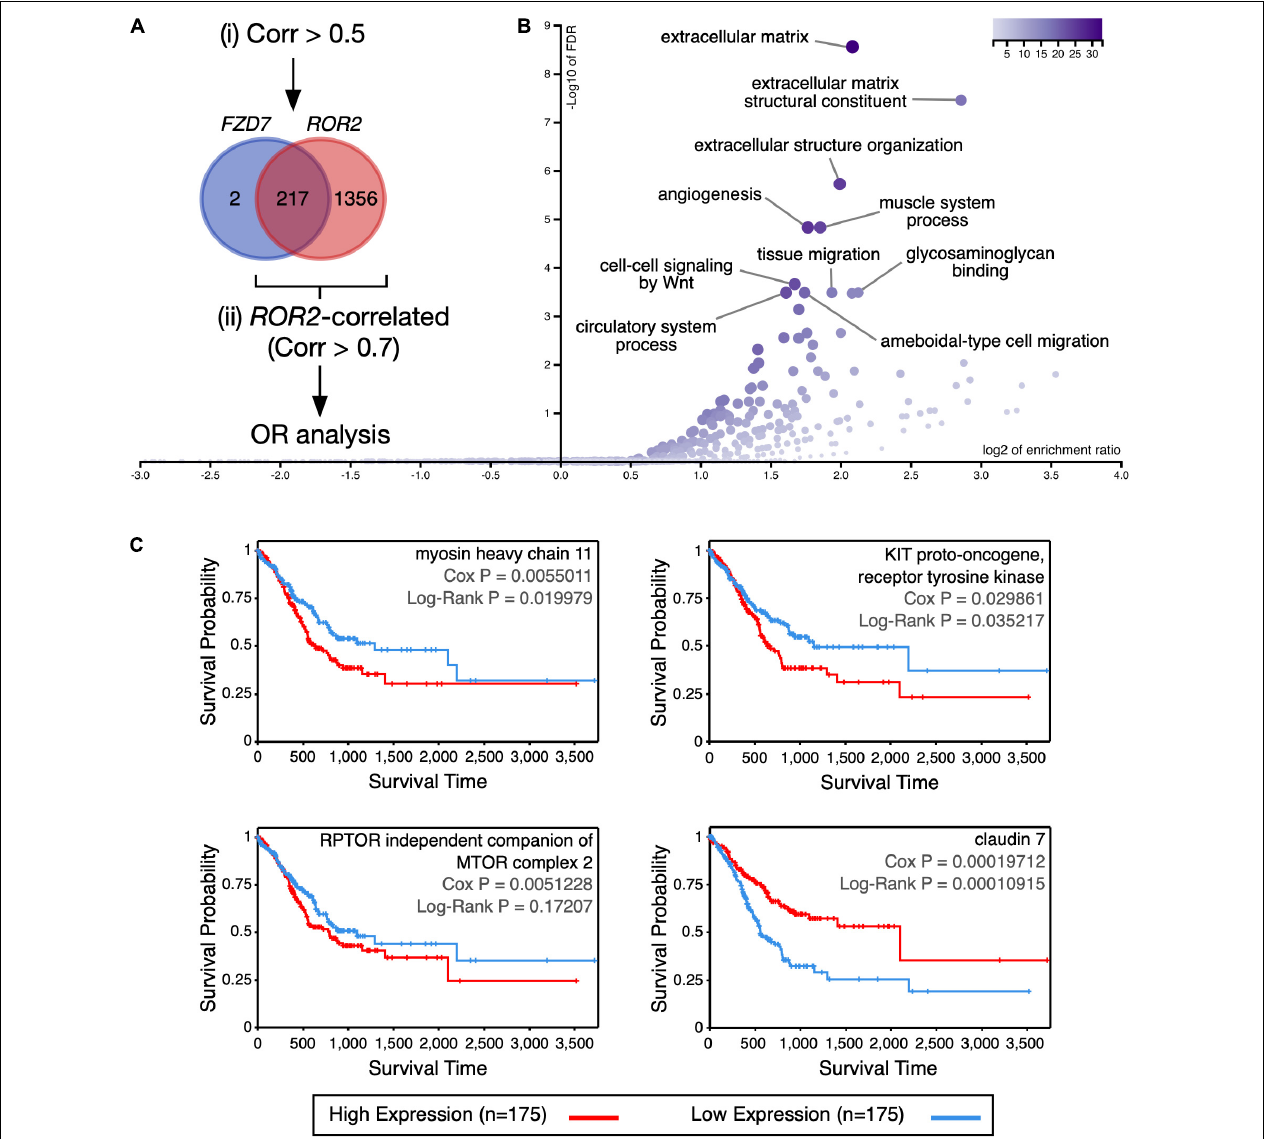
FIGURE 4 | Analysis of genes and proteins correlated with FZD7 / ROR2 expression. (A) Venn diagram showing the overlap between the genes positively correlated with either FZD7 or ROR2 gene expression. For simplicity, the size of the circles is not proportional to the number of genes. The rationale of the analysis is summarized in the diagram. (B) Volcano plot showing significantly over-represented (OR) Gene Ontology categories, according to WebGestalt. (C) Correlation between myosin heavy chain 11, KIT proto-oncogene, receptor tyrosine kinase, RPTOR independent companion of MTOR complex 2, and claudin 7 protein expression and survival, according to the TCPA